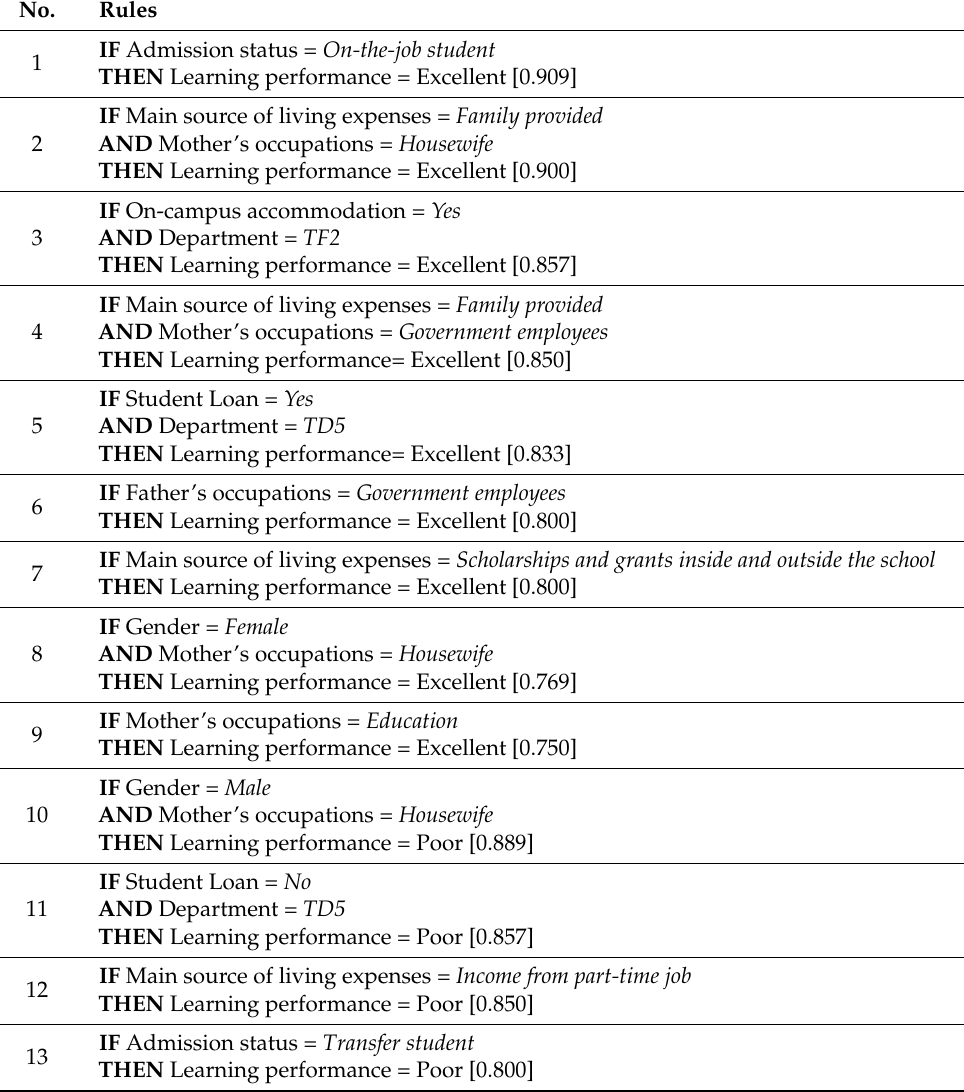
Table 10. Extracted rules by decision